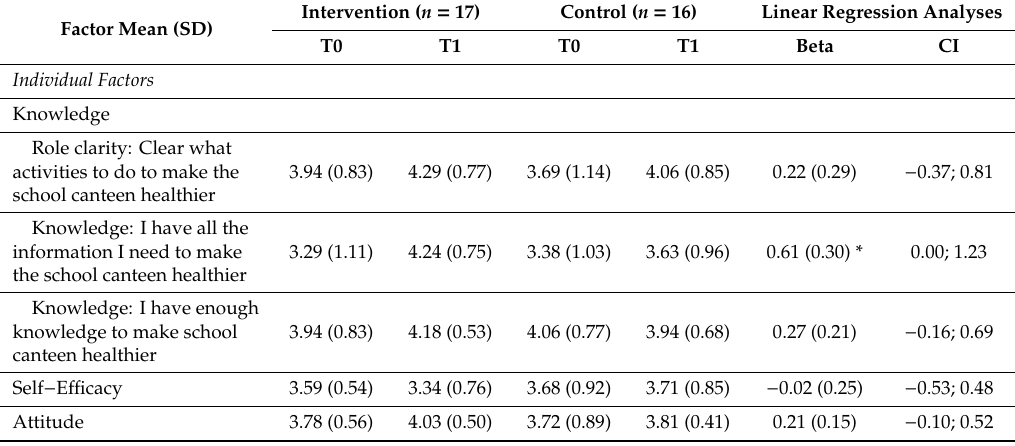
Table 3. The factors a ff ecting implementation perceived by stakeholders and di ff erences between intervention and control at follow-up